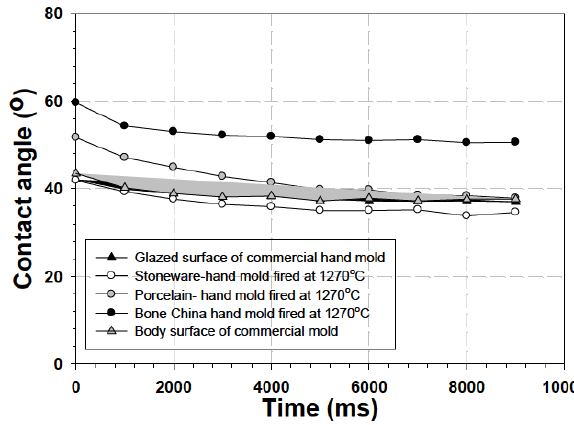
Figure 9: Contact angle vs. spreading time of natural rubber latex droplet on the ceramic hand mold surfaces